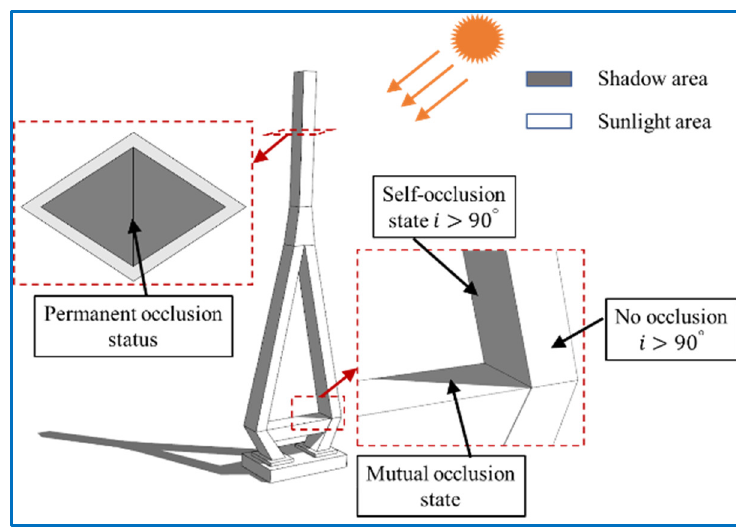
Figure 5. Shadow occlusion classification.